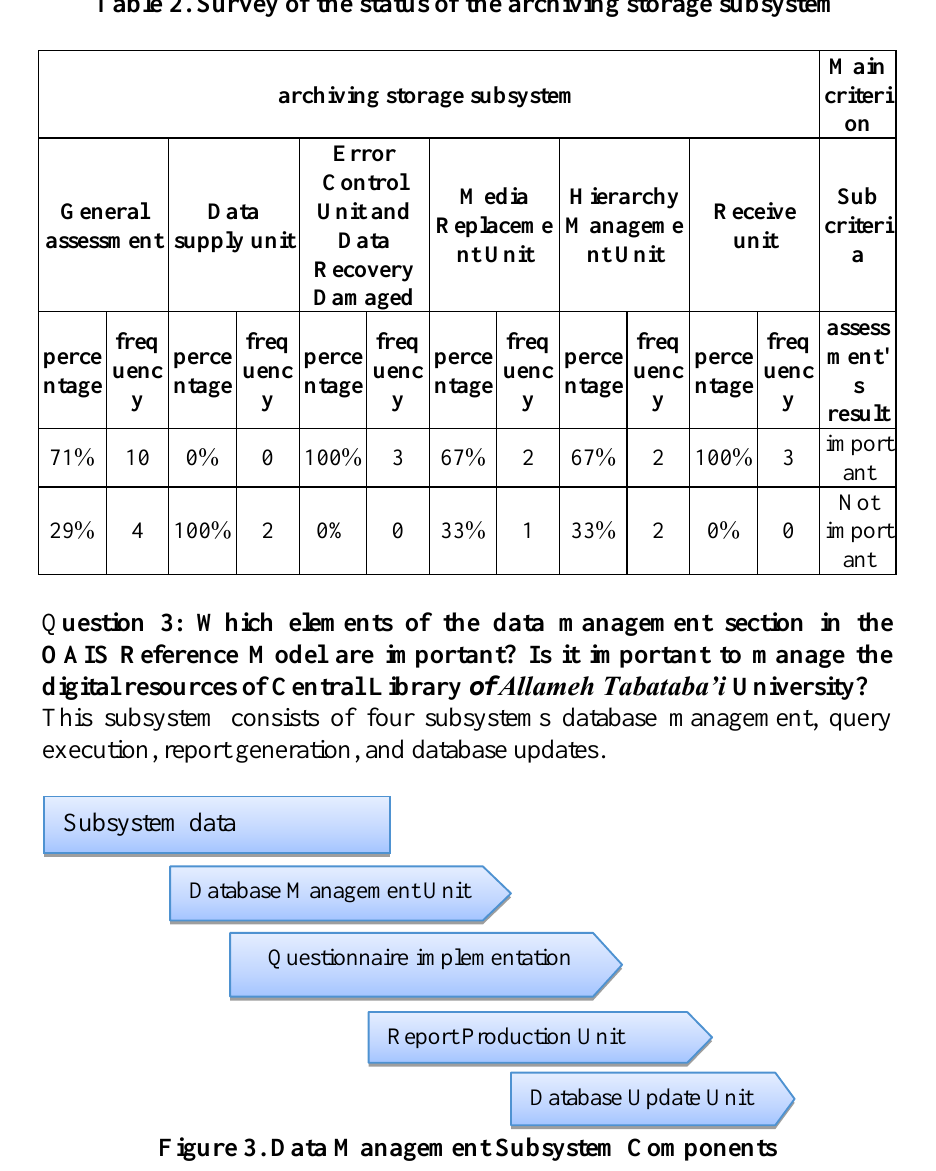
Table 2. Survey of the status of the archiving storage subsystem